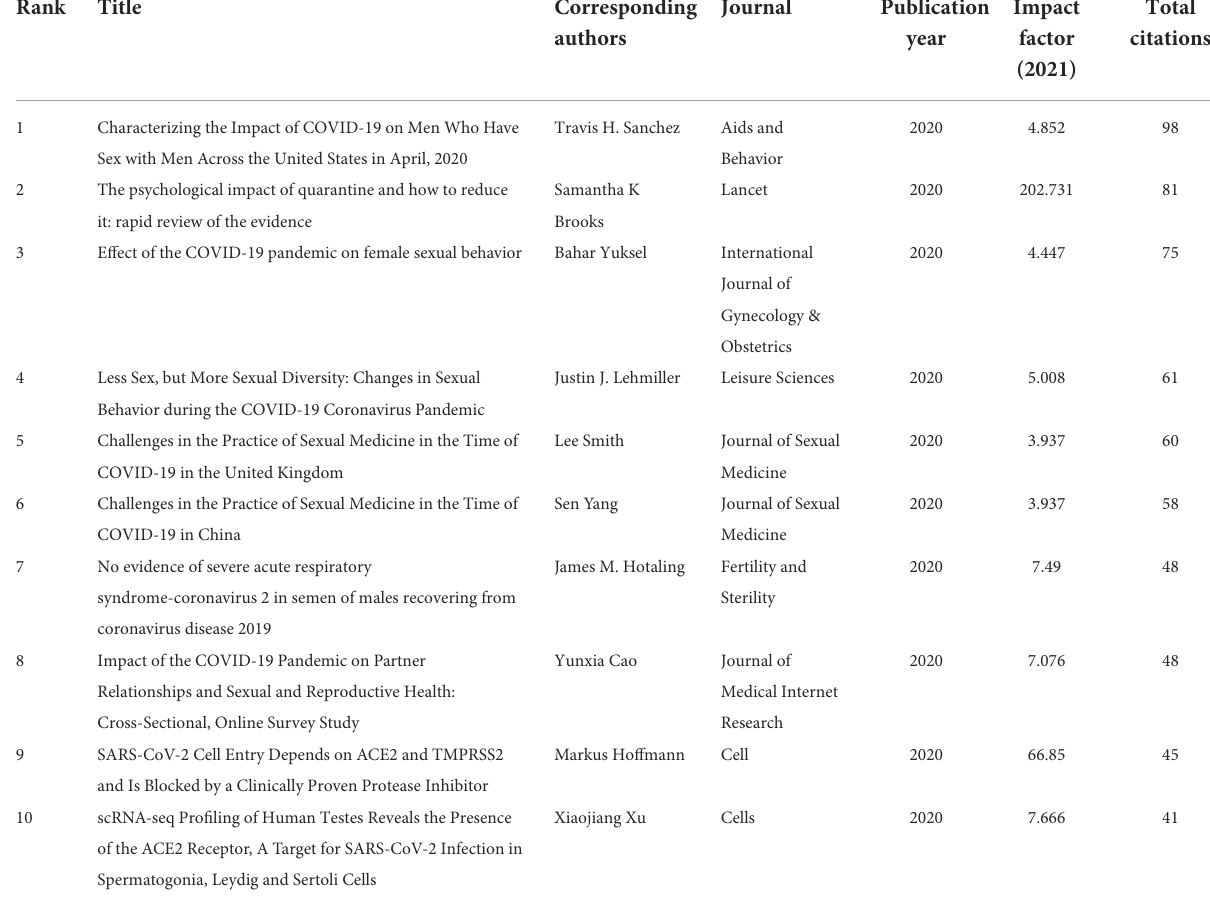
TABLE 4 Top 10 studies ranked by the total